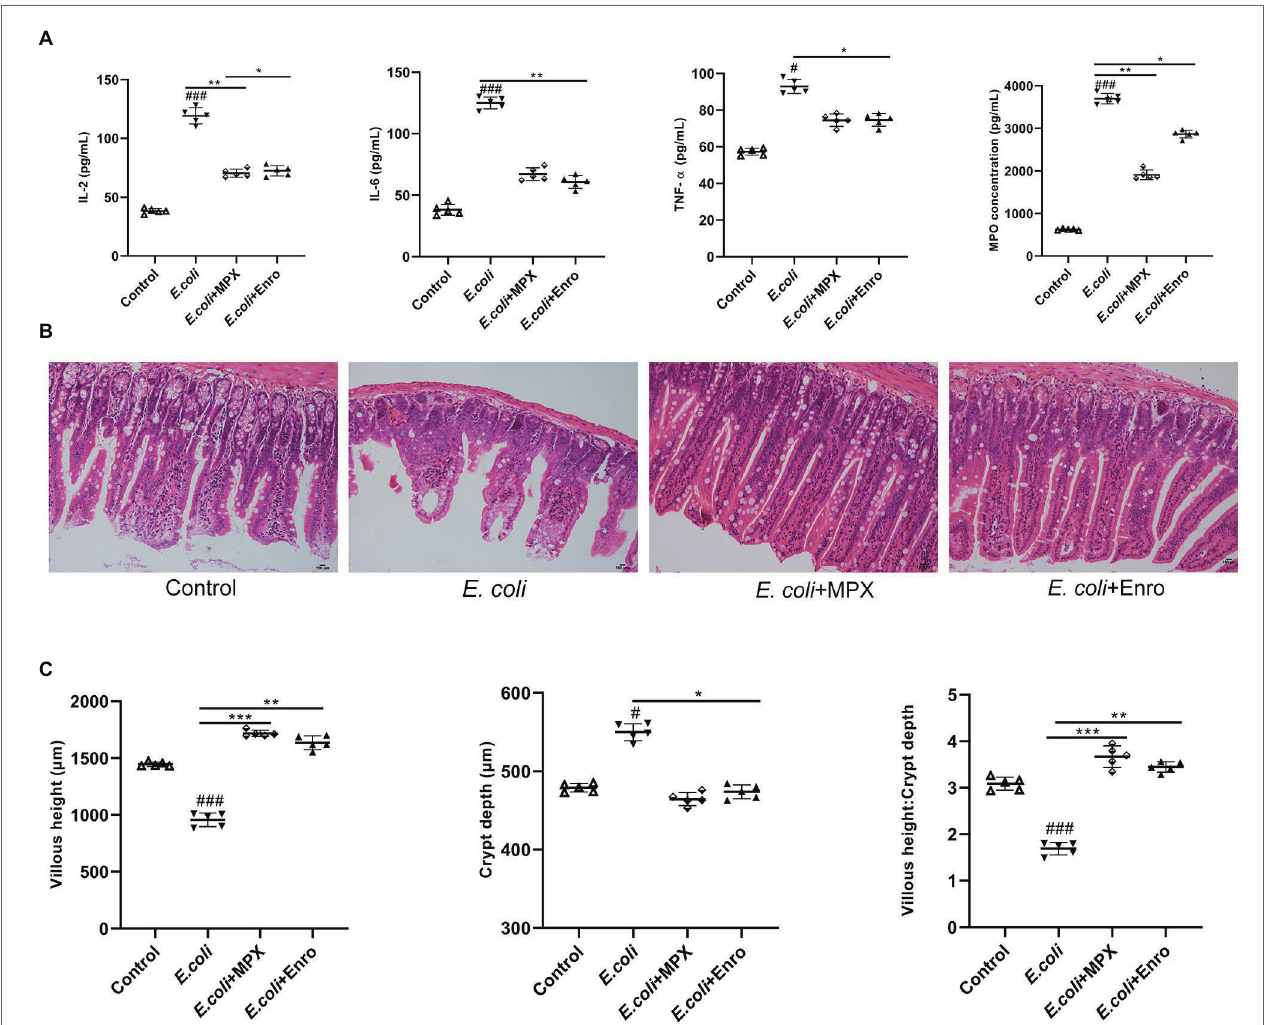
FIGURE 4 | MPX inhibits inflammatory cytokine expression and improves intestinal morphology. (A) The levels of inflammatory cytokines (IL-2, IL-6 and TNF- α ) and MPO in mouse serum were detected using ELISA. (B) The jejunum of mice was stained with H&E (bars, 100 μm); images were obtained at 200× magnification. (C) The length of jejunal villi, the depth of crypts, and the ratios of villi length to crypt depth were detected by ipwin32 software. Error bars represent mean ± SEM, n = 5. Statistical significance was defined as follows: # P < 0.05; ## P < 0.01; ### P < 0.001 E. coli vs control; * P < 0.05; ** P < 0.01; *** P < 0.001 MPX and Enro treatment vs E. coli